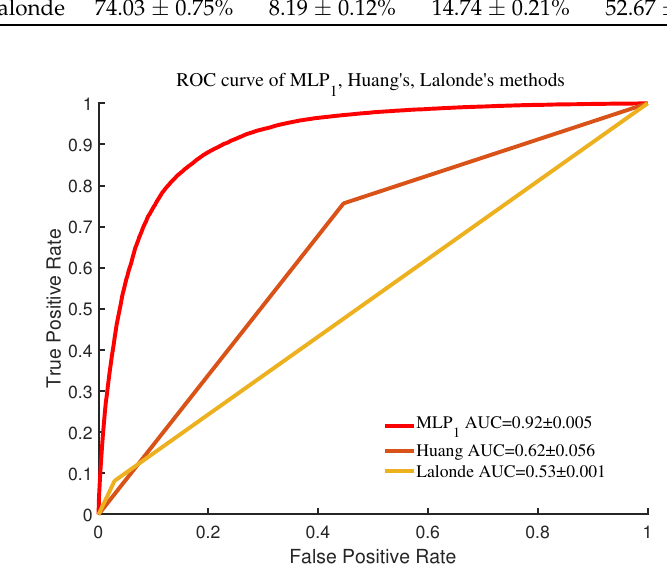
Figure 13. ROC curves of the proposed shadow detection system (i.e., MLP 1 ), Huang’s and Lalonde’s approaches. Note that the MLP 1 achieved the highest AUC = 0.92 ±